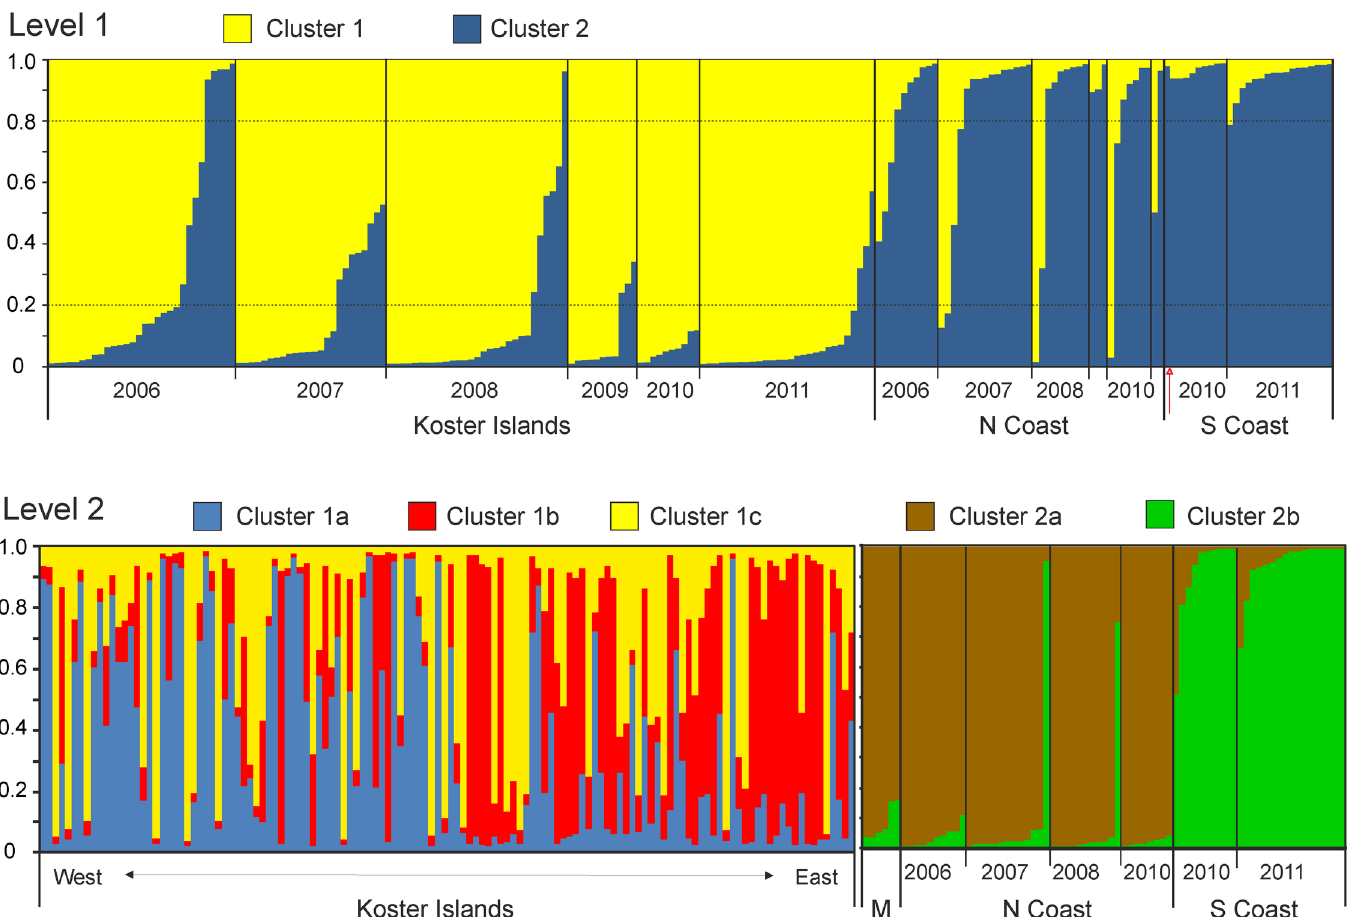
Fig 4. Bayesian assignment of American mink from Sweden in the genetic clusters identified by STRUCTURE analysed in two hierarchical levels. Each American mink is represented by a single vertical bar. The locality of origin and year of capture for each individual is indicated below. Dashed black lines indicate the threshold probabilities of 0.80 and 0.20, used to assign each individual to a single cluster. Red arrow indicates one individual from the South Coast which was caught in 2007 and was included with the group of mink caught in 2010. M – indicates individuals from Koster Island assigned as migrants from the coast at level